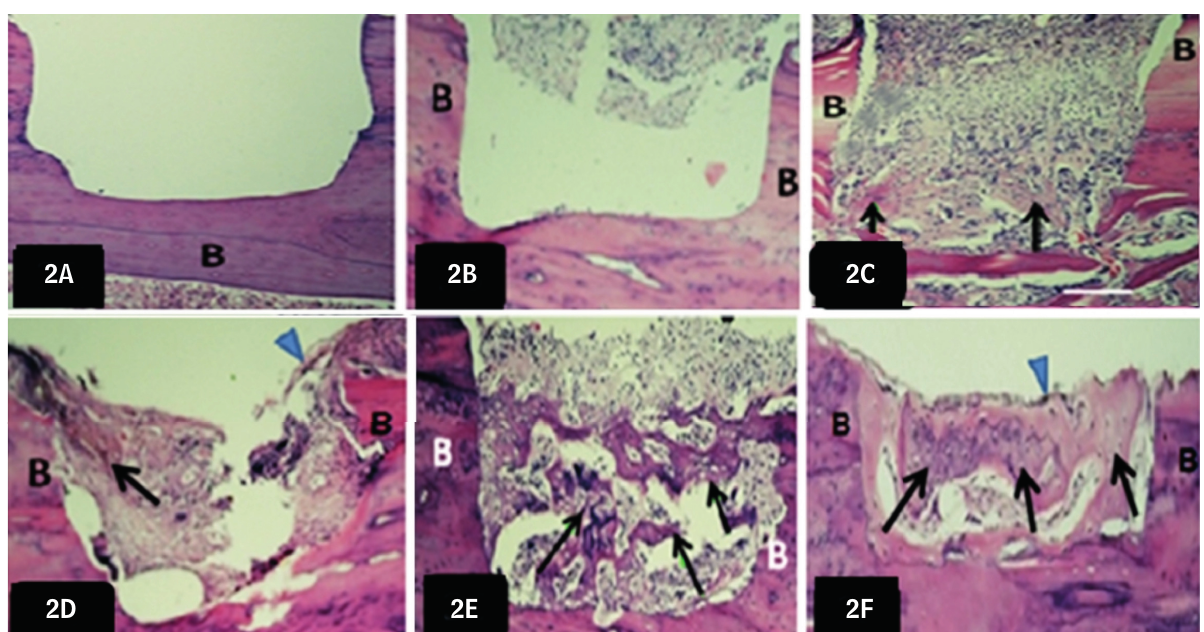
Figure 2 - Light micrographs of longitudinal sections of callus tissue stained with HE Note: A, D–C Group; B, E–L Group; C, F–I Group. 2 A, B, C – At the end of the fi rst week; 2 D, E, F – At the end of the third week. New bone formation can be seen at the end of the fi rst week (7 th day) in I group (C) but not in the C (A) or in L Group (B). At the end of the twenty fi rst week fractures treated with US of 1.0 W/cm² (F) healed more rapidly than did that treated with US of 0.5 W/cm² (E) or the controls (D). Arrowheads – Periosteum. Arrows – Newly formed bone; B– Bone tissue. HE staining. Bar: 0.5mm. Source: Research data.